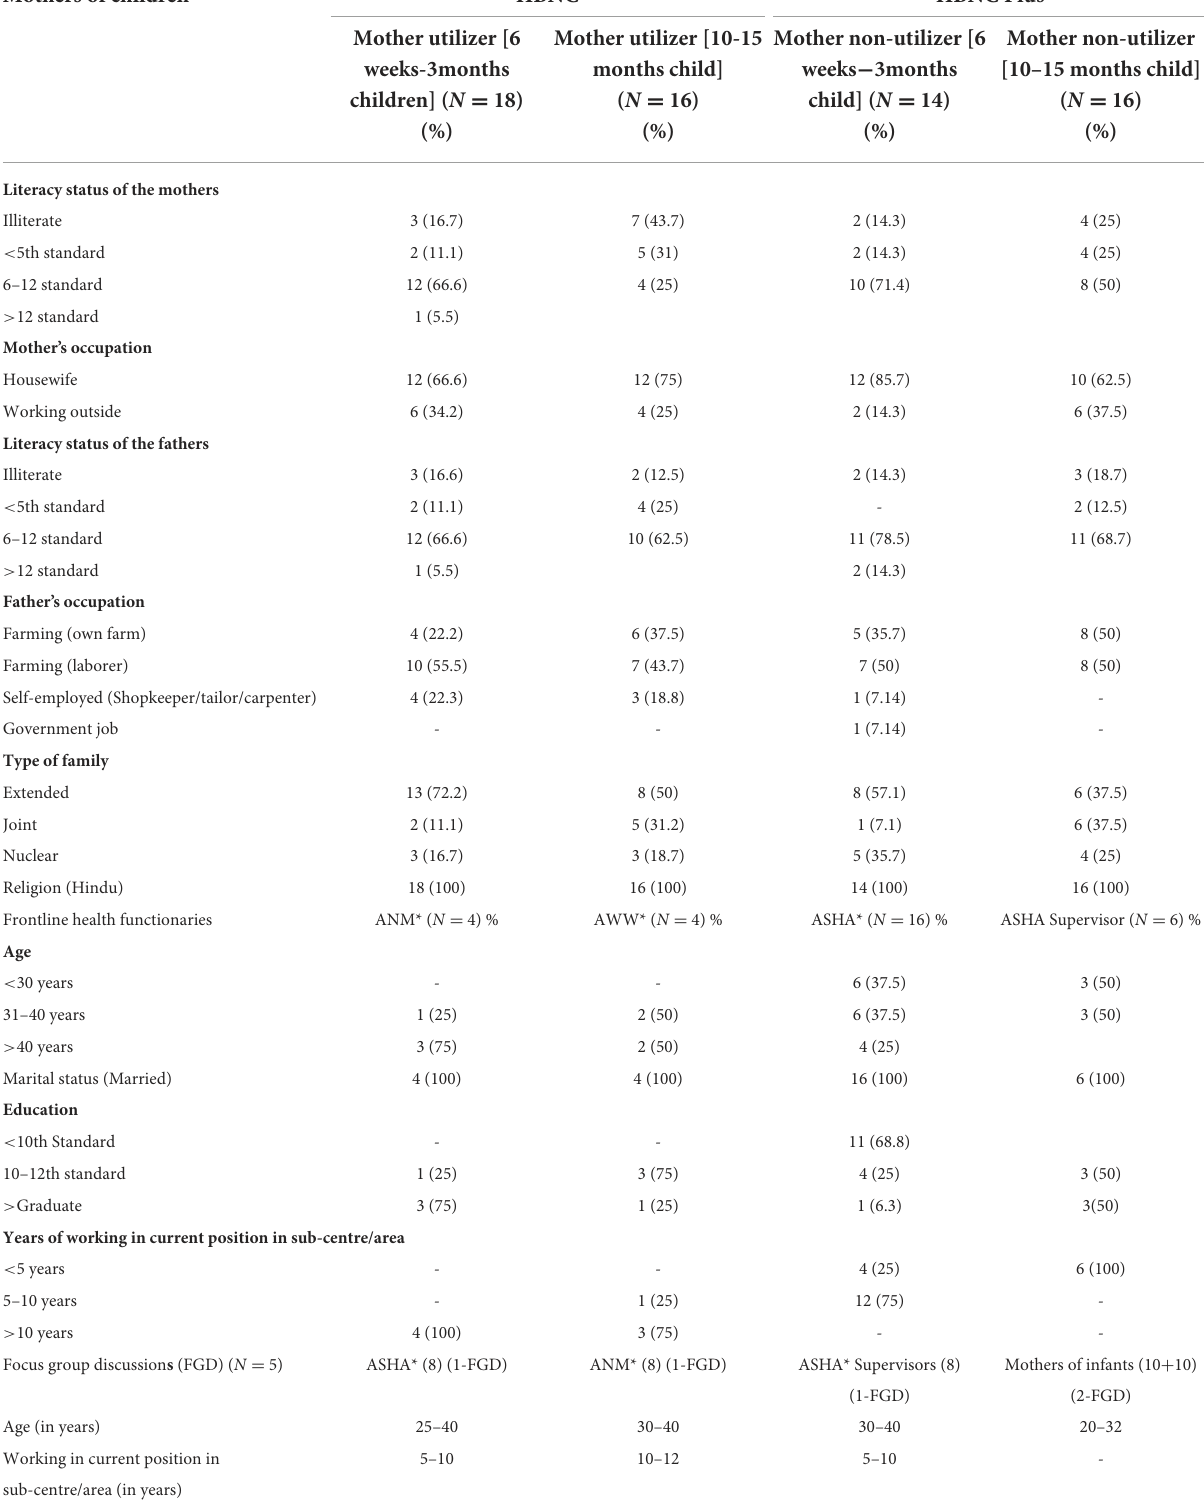
TABLE 1 The socio-demographic characteristics of the study participants. Mothers of